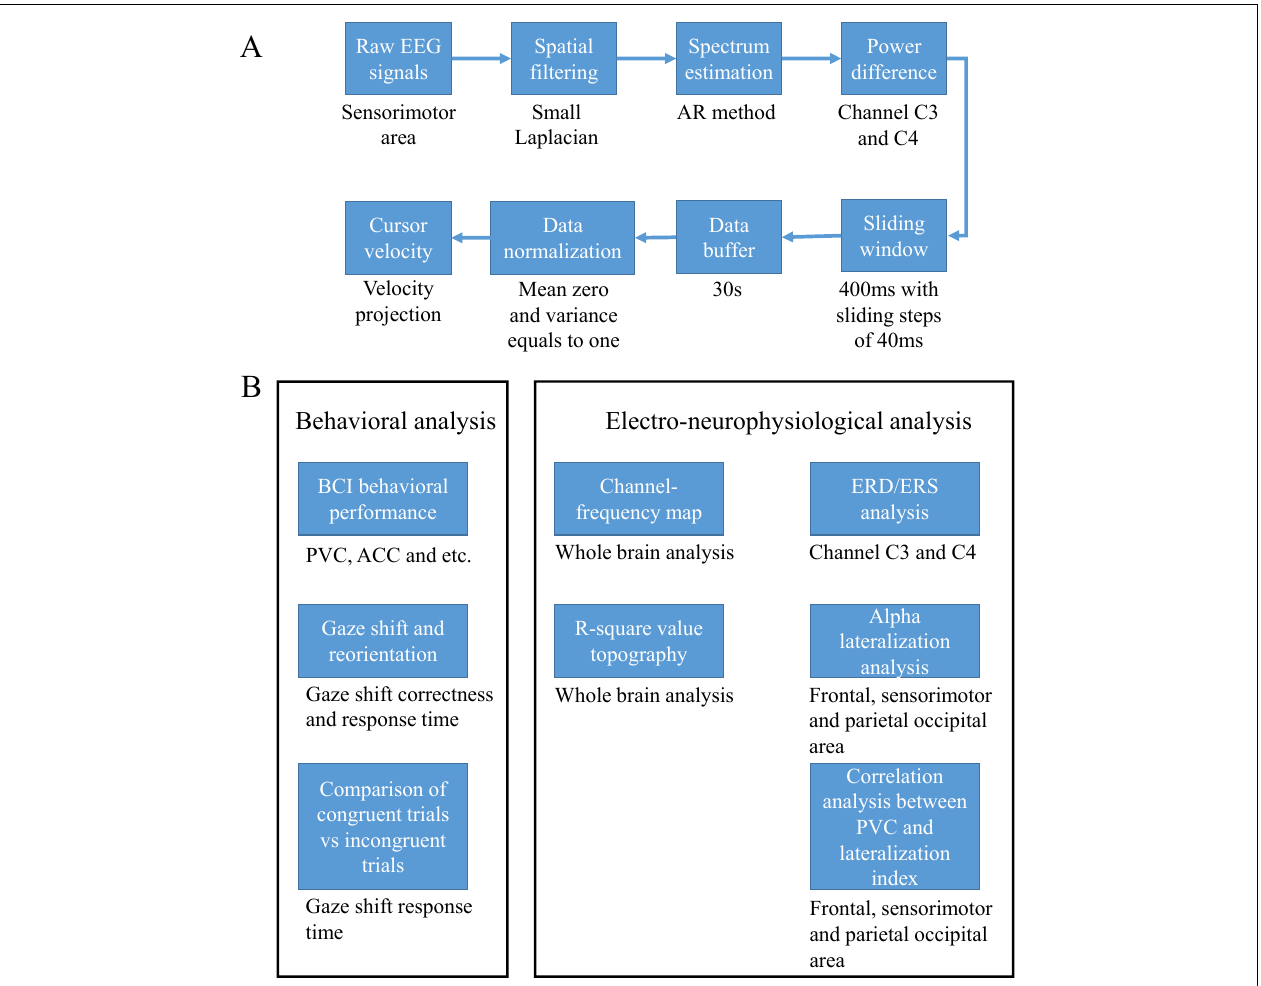
FIGURE 3 | (A) Online signal processing flow chart and (B) schematic of the offline data analysis.